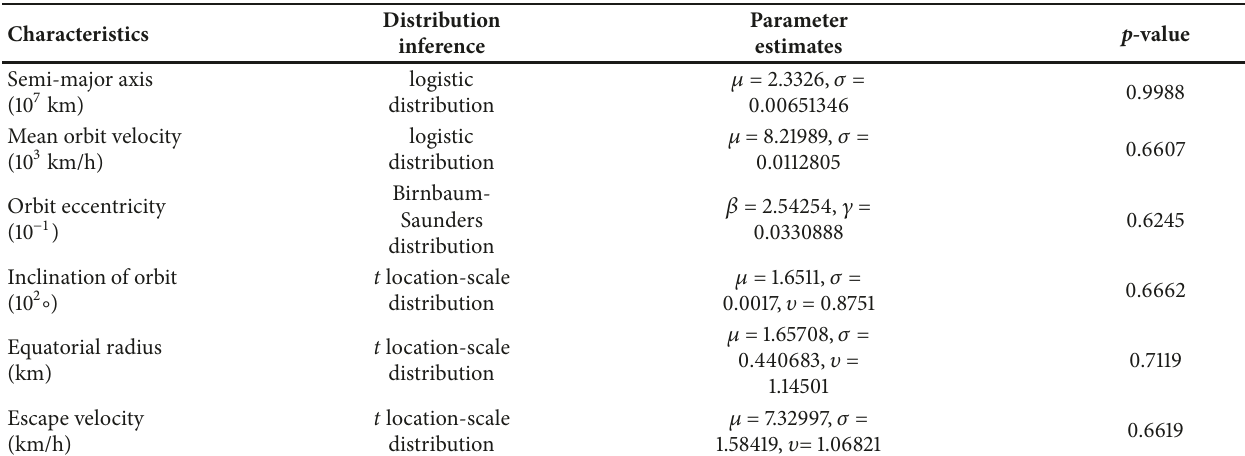
Table 2: The distribution inference in each physical and orbital characteristic (Carme